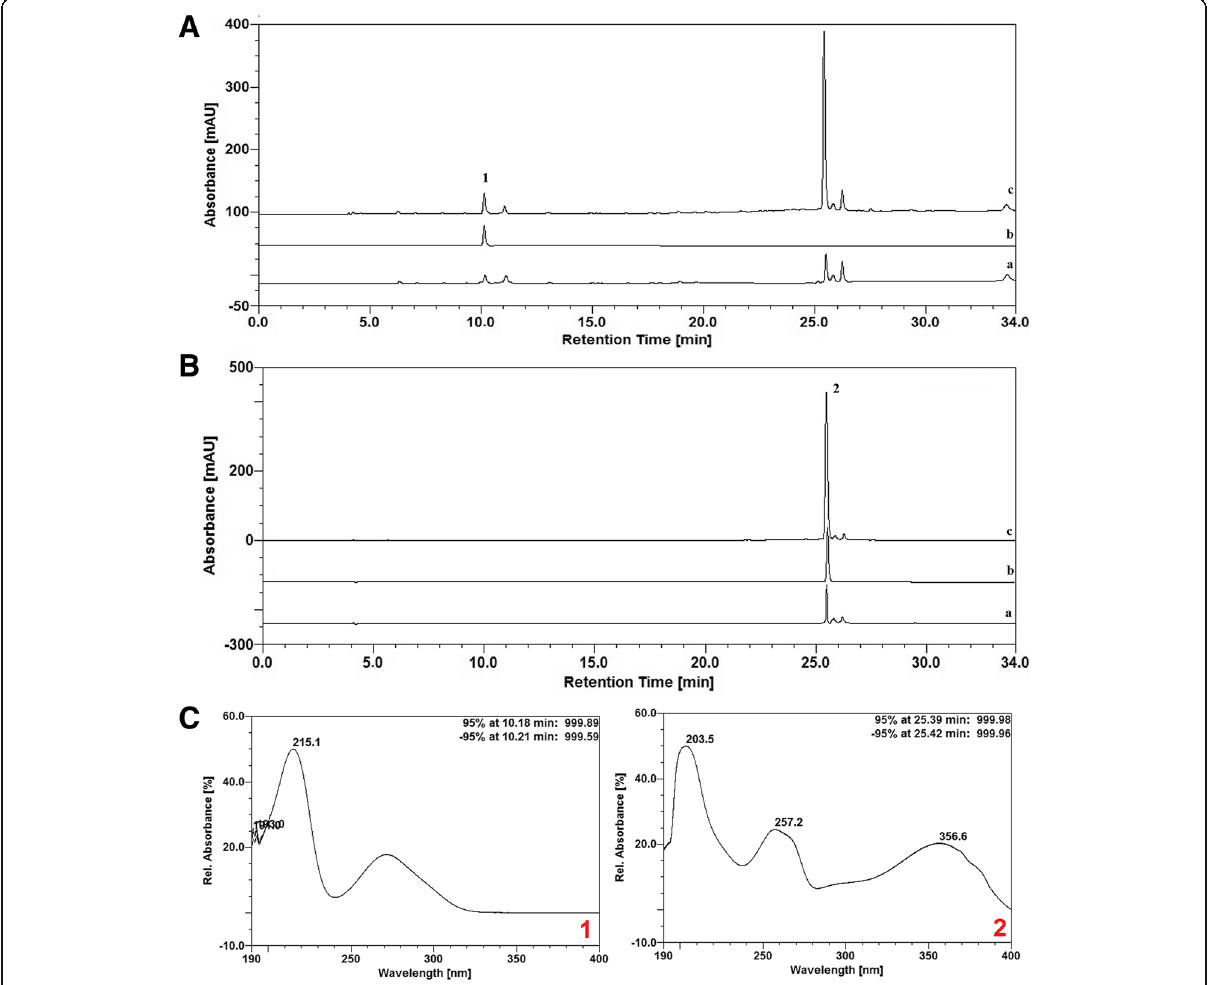
Fig. 1 HPLC-DAD analysis of hexane extract from Spondias tuberosa leaf. Chromatographic fingerprint at 270 ( a ) and 350 ( b ) nm showed the presence of gallic acid (1) and hyperoside (2), as indicated by the retention times. c Scanning spectra of peaks 1 and